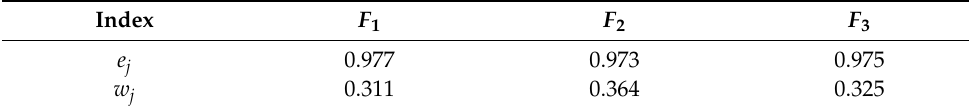
Table 12. The expert weight.